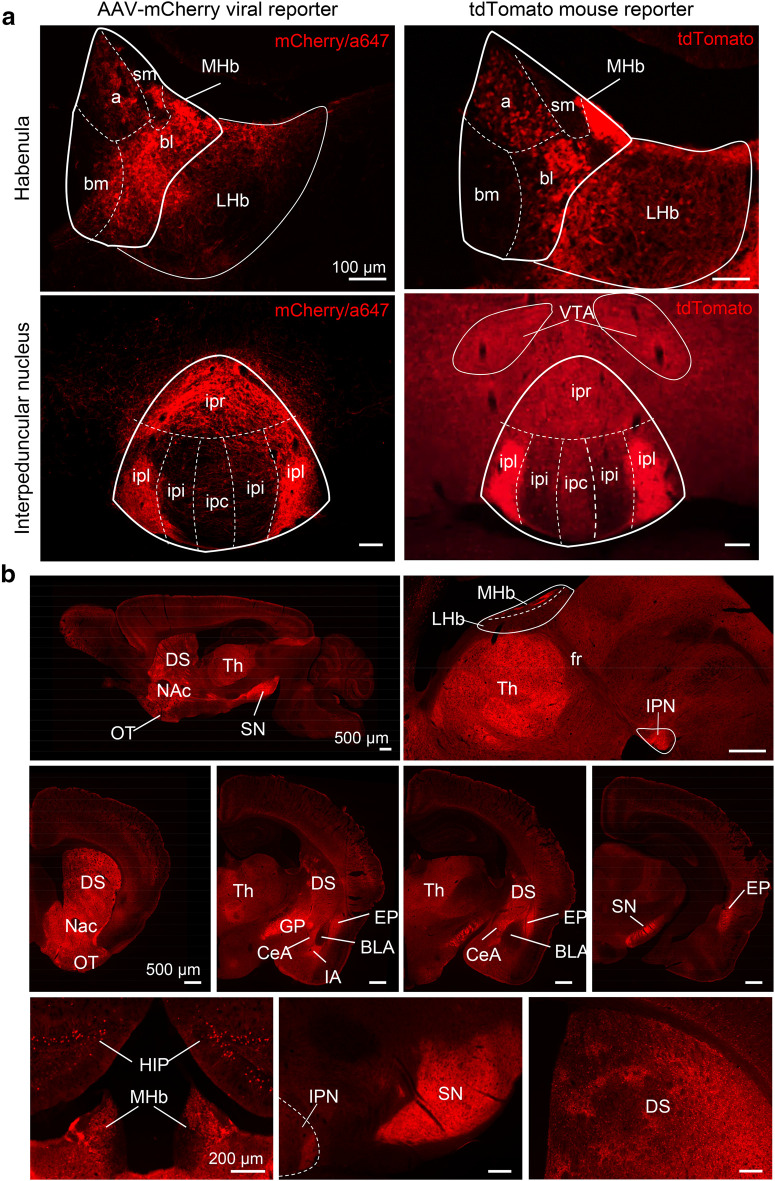
Cre-mediated recombination is efficient in the Oprm1-Cre line. a, Cre-mediated expression of the fluorescent reporter tdTomato in the habenula–interpeduncular pathway. Left, Cre recombination on local injection of an AAV2.EF1a.DIO.mCherry viral reporter in the MHb; right, Cre recombination on breeding Cre-dependent tdTomato reporter mice with the Oprm1-Cre line both lead to a strong fluorescent signal apical (a) and basolateral (bl) of the MHb, as well as in the rostral (ipr) and lateral (ipl) areas of the IPN. Scale bar, 100 μm. b, Cre-mediated tdTomato expression in the adult brain of Oprm1-Cre × tdTomato mice. Top, Whole-brain sagittal views show high tdTomato expression in the thalamus, as well as the entire mesolimbic (left) and MHb-IPN (right) pathways. Scale bar, 500 μm. Middle, Coronal sections show strong fluorescence in the basal ganglia and thalamus, as well as in most amygdalar nuclei with the notable exception of basolateral amygdala. Scale bar, 500 μm. Bottom, Higher-magnification highlights both cell bodies and/or fibers patterns of labeled neurons. Scale bar, 200 μm. Slides were scanned on the Olympus VS120 with a 10× objective. BLA, Basolateral amygdala; CeA, central amygdala; EP, endopiriform nucleus; fr, fasciculus retroflexus; GP, globus pallidus; HIP, hippocampus; IA, intercalated amygdala; LHb, lateral Hb; OT, olfactory tubercle; Th, thalamus.